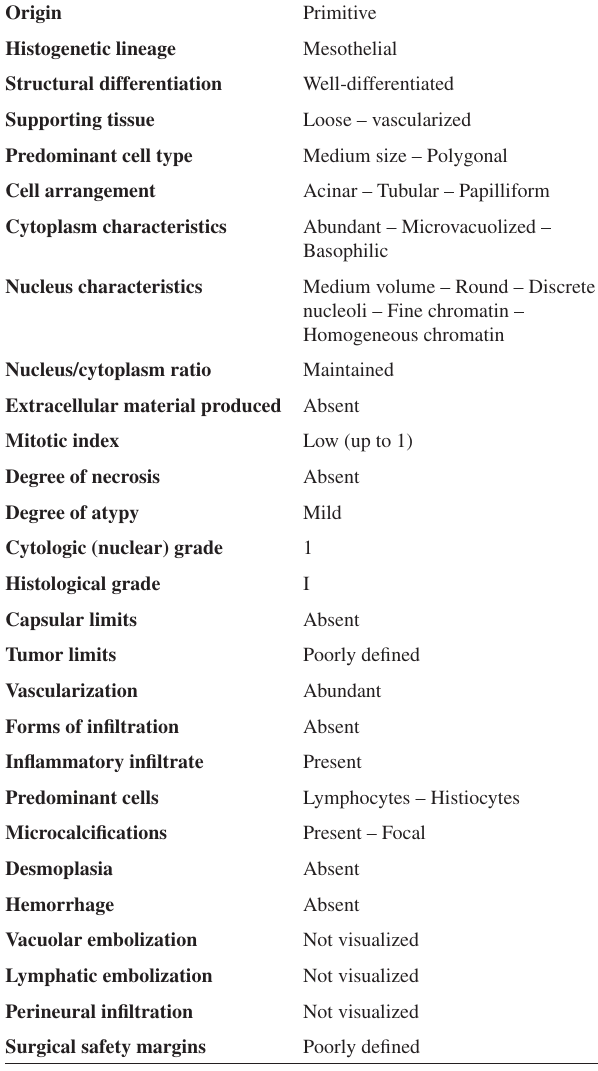
Table 1 - Histopathological findings of the reported case